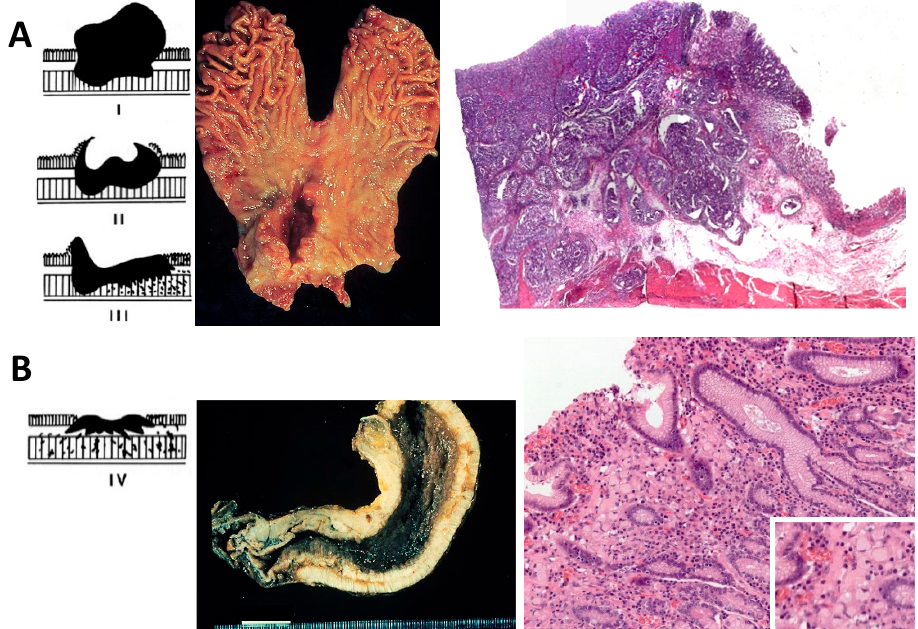
Figure 2. Schematic Borrmann classification, gross pathology, and histological view of intestinal ‐ and diffuse ‐ type gastric cancer. ( A ) Intestinal ‐ type gastric cancer, the left panel shows schematic Borrmann types polypoid (type I), fungating (type II), and ulcerating (type III); the middle panel shows a total gastrectomy specimen with a Borrmann II gastric cancer in the antrum, lesser curvature, and anterior wall; right panel shows a histological scan view of gastric cancer forming glands and occasional papillary structures infiltrating up to the muscularis propria; non ‐ tumor adjacent gastric mucosa is seen to the right. ( B ) Diffuse ‐ type gastric cancer, the left panel shows schematic Borrmann classification with diffusely infiltrating carcinoma (type IV), the middle panel shows a total gastrectomy specimen in which the entire gastric wall is thickened, hard, and infiltrated by tumor; left panel shows a signet ‐ ring cell diffuse ‐ type gastric cancer with tumor cells with a mucin droplet pushing and flattening the nucleus to the side and infiltrating the lamina propria without a desmoplastic reaction; the inset shows a higher magnification (400×) of tumor cells. Schematic Borrmann classification was taken from Lecciones de Anatomía Patológica with permission [18].